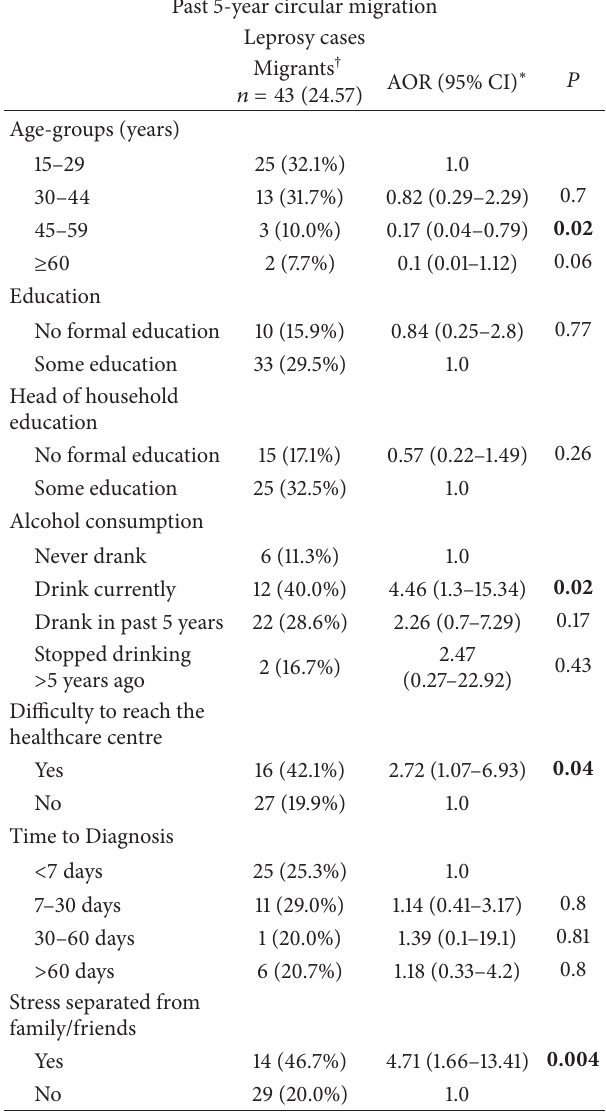
Table 6: Multivariate analysis of factors associated with past 5 year circular migration among migrants in a clinically unapparent population without symptoms of leprosy compared to clinically unapparent non-migrant